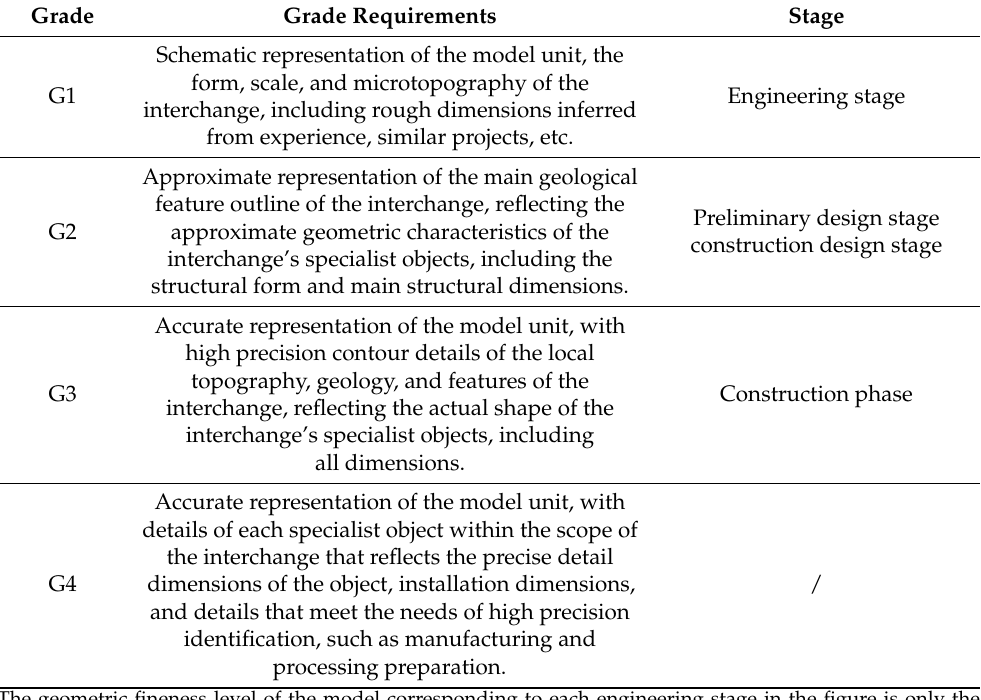
Table 4. Classification of BIM components’ geometric accuracy.